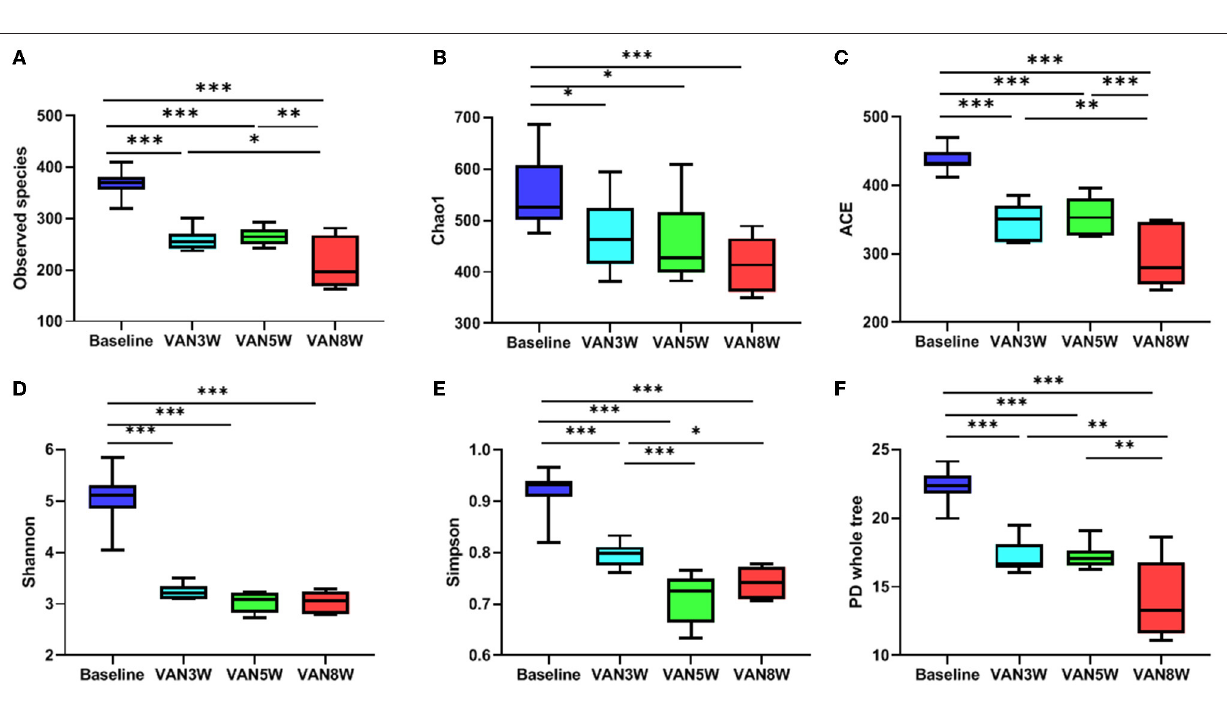
unchanged up to 28 weeks. The decreased primary BAs included taurine, taurocholic acid (TCA), cholic acid (CA), glycocholic acid (GCA), and chenodeoxycholic acid (CDCA) (all p